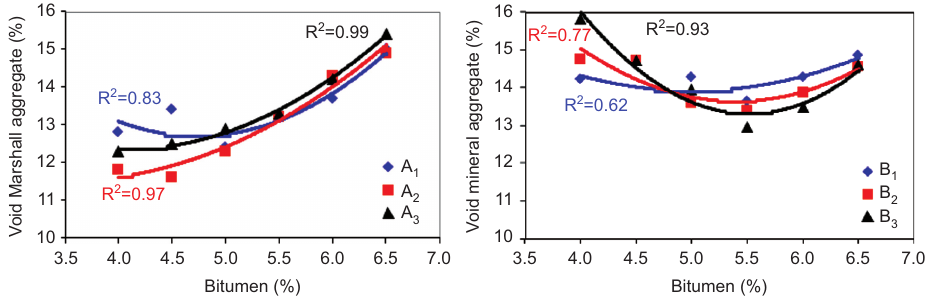
Figure 10 Relation between % bitumen and % VMAs.